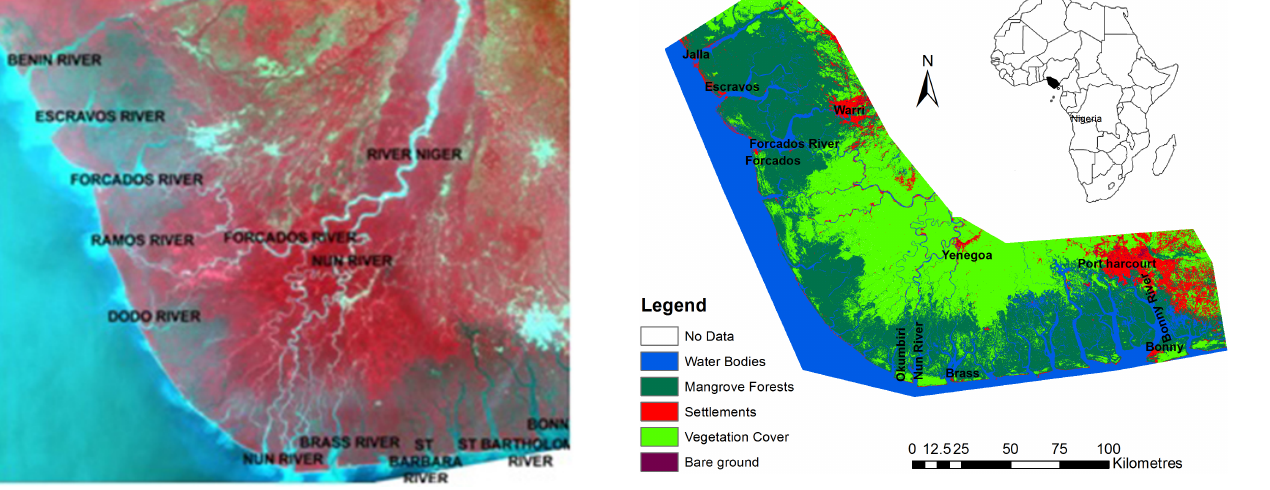
Figure 1. NigeriaSatX satellite image showing rivers in the Niger delta.